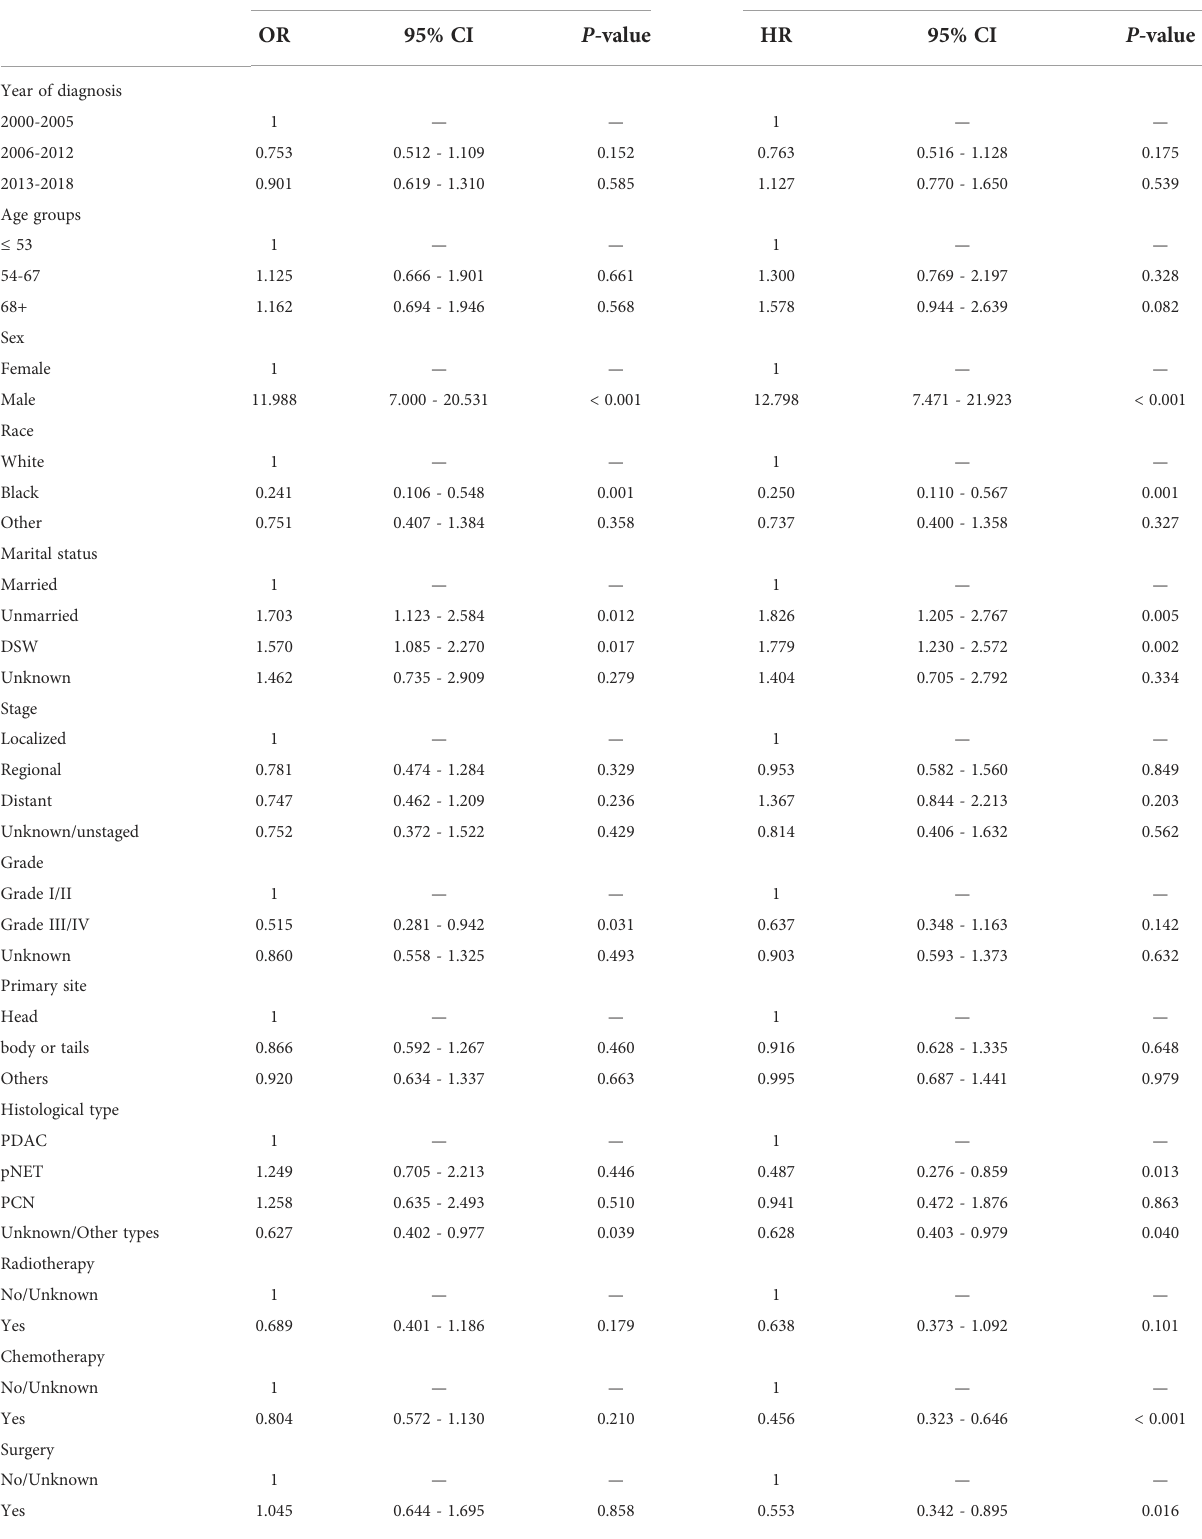
TABLE 2 Odds ratios and hazard ratios of suicide among pancreatic cancer patients (2000-2018) by multivariate